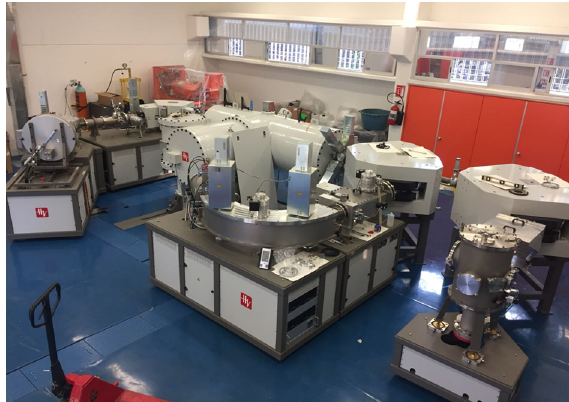
Figure 2. 1 MV Tandetron of the Accelerator Mass Spectrometry National Laboratory, LEMA IFUNAM, Mexico, which was used for the AMS stage of the present